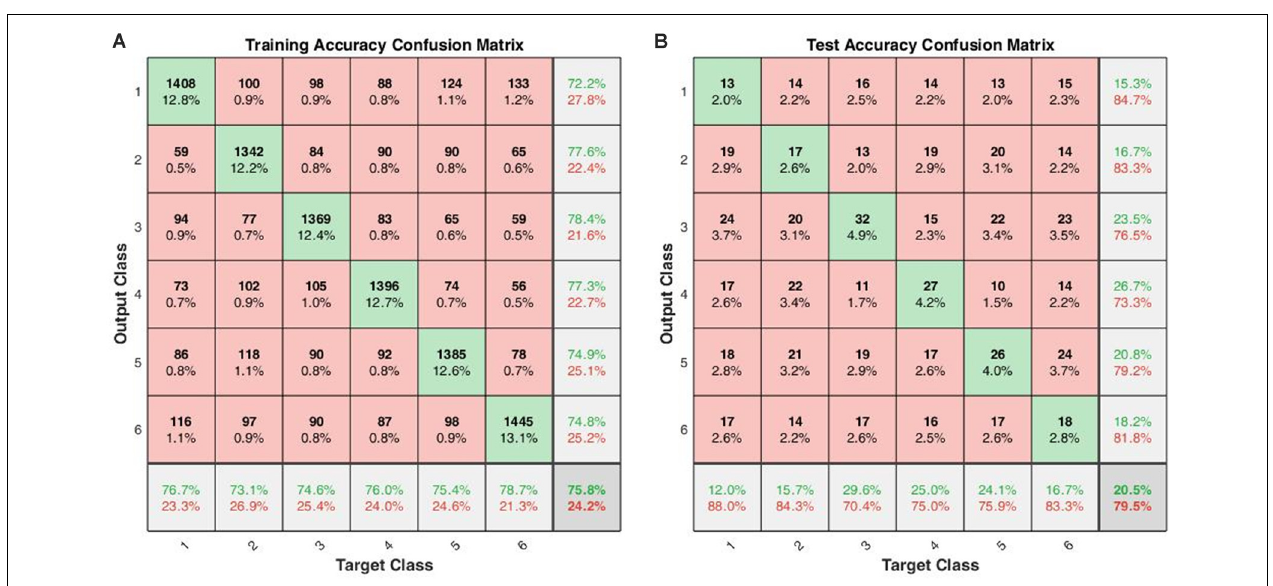
the training data set was bigger in the leave-one-out